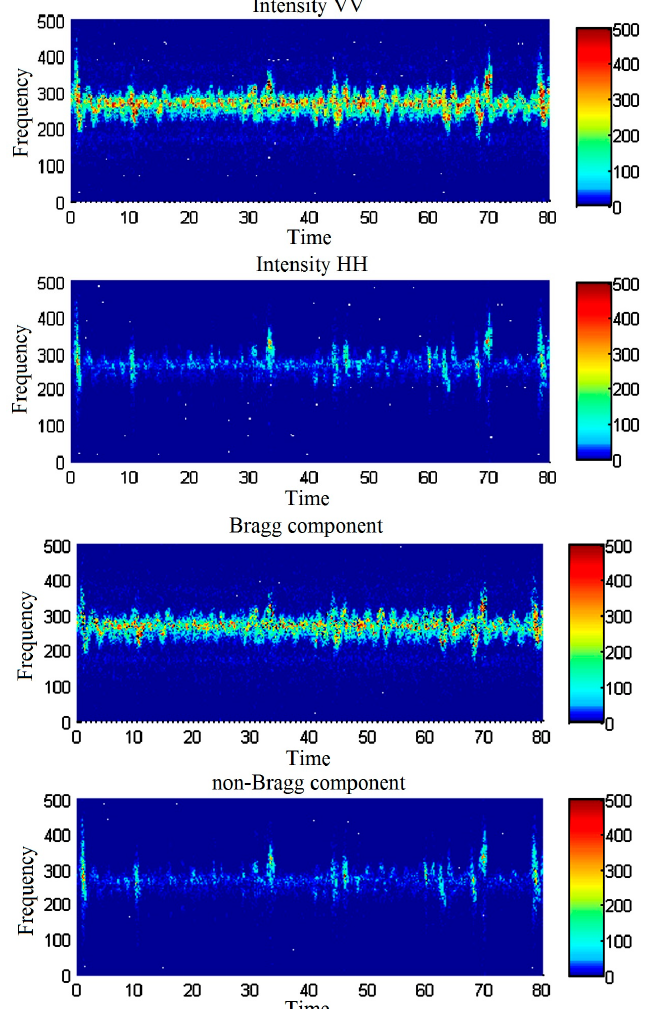
Figure 5. Spectrograms of radar backscatter at VV and HH polarizations ( two upper panels ) and of Bragg and non-Bragg components of radar return ( two bottom panels ). Upwind observations, wind velocity of 8 m/s, incidence angle of 60°. The frequency offset 250 Hz corresponds to “zero” Doppler shift, time in seconds. Clean water.